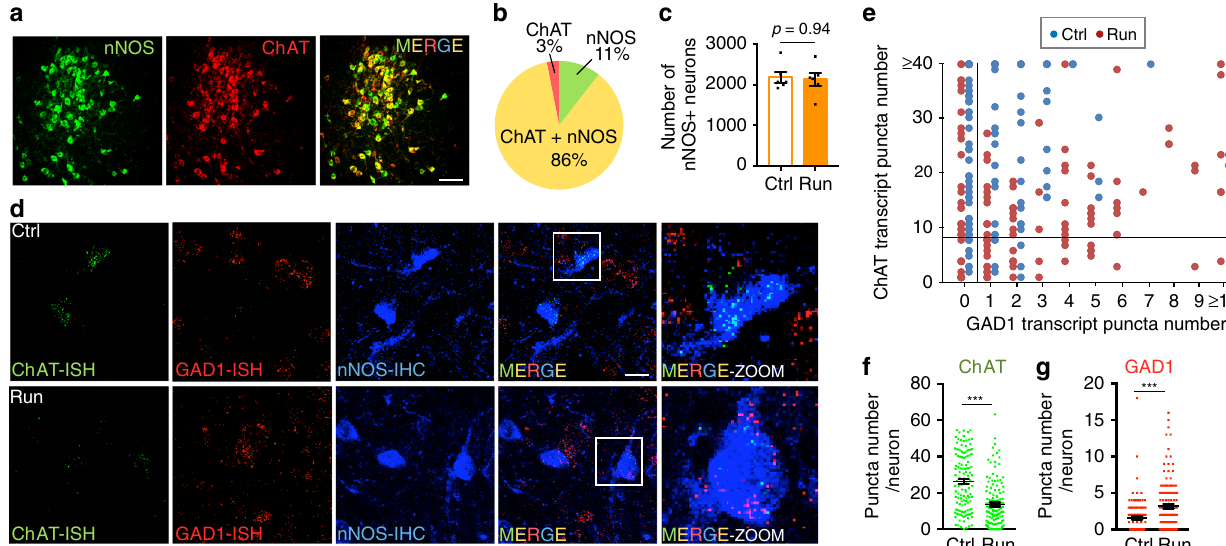
Fig. 4 A subset of cPPN nNOS neurons of runner mice lose ChAT transcripts and gain GAD1 transcripts. a Double staining of the cPPN in a non-runner control mouse for nNOS (green) and ChAT (red). Scale bar, 100 μ m. b Co-localization of nNOS and ChAT in the cPPN. For a , b , n = 1068 cells from three non-runner control mice. c Stereological counts of DAB staining of nNOS in control and 1-week runner cPPNs. n = 6 animals per group. Mann – Whitney U test. NS, not signi fi cant. d Triple staining of ChAT and GAD1 transcripts and nNOS protein in the cPPN of a control and a 1-week runner mouse. Right panels are boxed regions in merged images at higher magni fi cation. Scale bar, 20 μ m. e Scatterplot of numbers of in situ stained ChAT puncta ( y -axis) against numbers of in situ stained GAD1 puncta ( x -axis). Each dot represents one neuron. The vertical line divides neurons that contain zero from those containing more GAD1 transcript puncta and the horizontal line divides neurons that contain less from those containing more than eight ChAT transcript puncta. f , g Y-axes are the mean number of ChAT ( f ) and GAD1 ( g ) fl uorescent puncta in single nNOS + neurons. For d – g , n = 4 animals per group; n = 123 cells for Ctrl and 137 cells for Run. Statistical signi fi cance * p < 0.05, *** p < 0.001 was assessed by two-sided Welch ’ s t -test. Data shown are mean ±